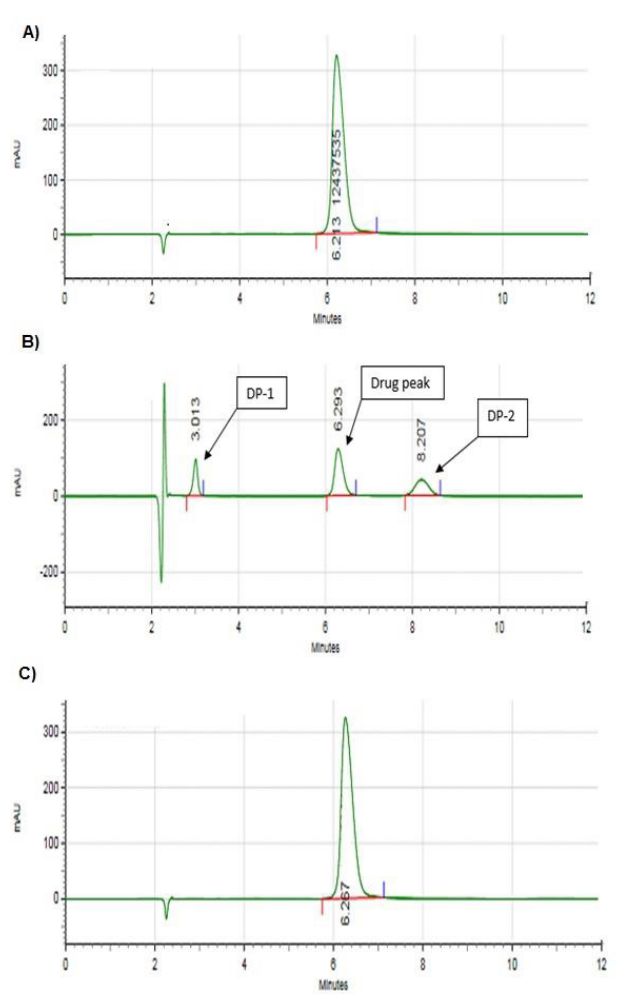
FIGURE 3 - Representative chromatograms of stress samples after degradation in A) Acidic B) Basic and C) Neutral